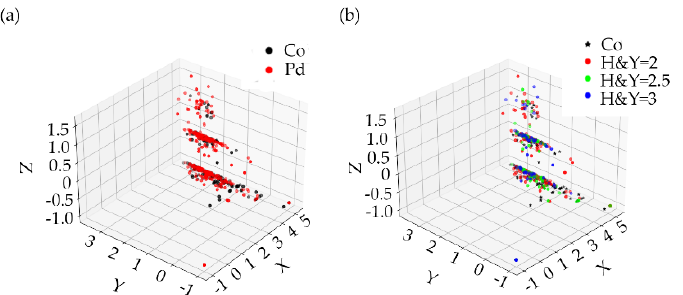
Figure 6. ( a ) Persistent entropy between control and PD subjects. ( b ) Persistent entropy between control subjects and PD subjects with different disease grades.